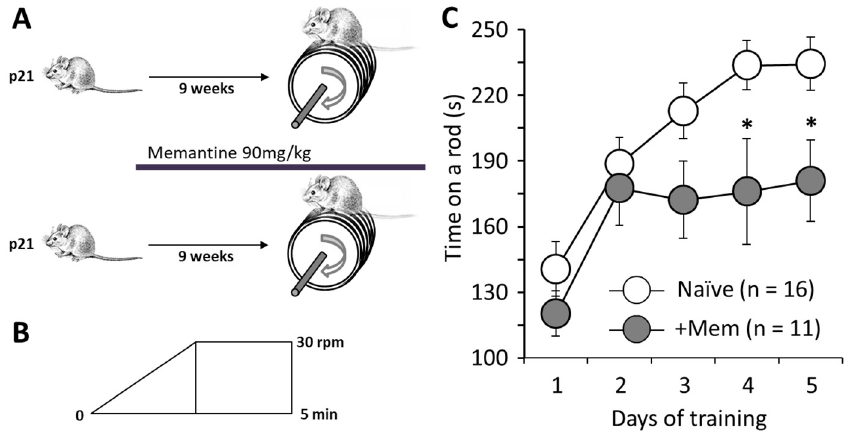
Figure 1. Long-term administration of memantine impairs the motor behavior in mice. ( A ) Experimental groups: control mice did not receive any medication, while the test group consumed me- mantine (up to approximately 90 mg/kg ∙ day in drinking water) from postnatal day 21 (p21) for 9 weeks. ( B ) Accelerated rotarod protocol. Speed increased from 0 to 30 rpm during first 3 min and then kept stable for 2 min. ( C ) Averaged data of rotarod performance in control mice (opened cir- cles) and mice treated with memantine (grey circles) over 5 days of testing. (* p < 0.05; t -test, followed by post-hoc Tukey’s HSD test for p -values adjusted for multiple comparisons; n is number of mice in each group).